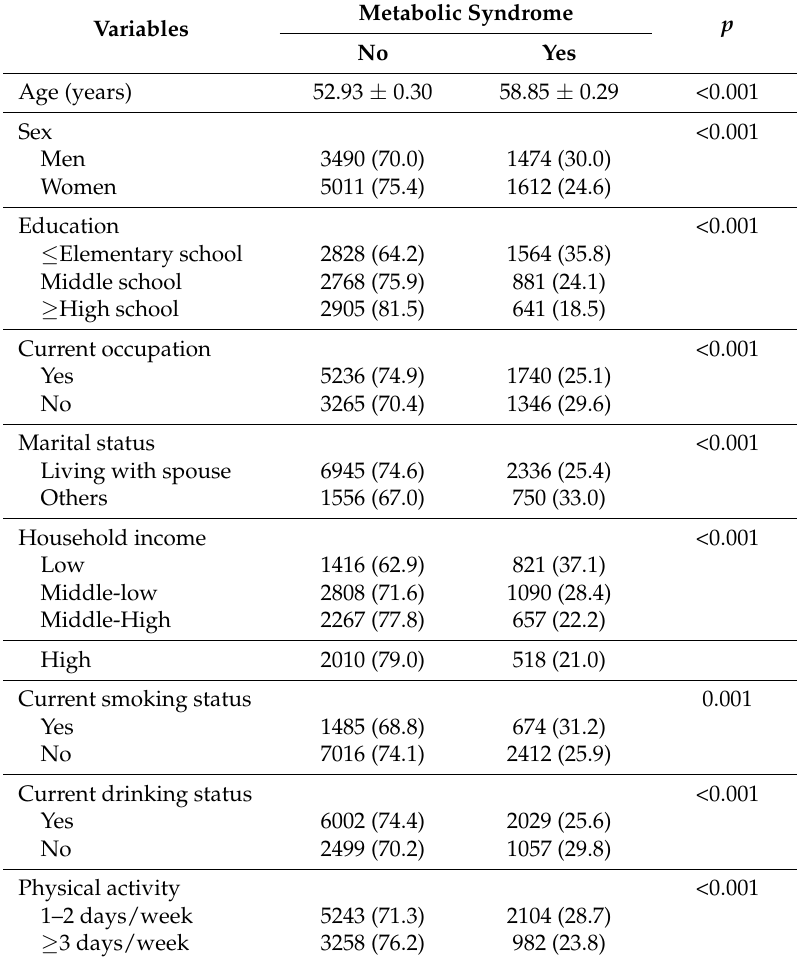
Table 1. Prevalence of metabolic syndrome according to the subjects’